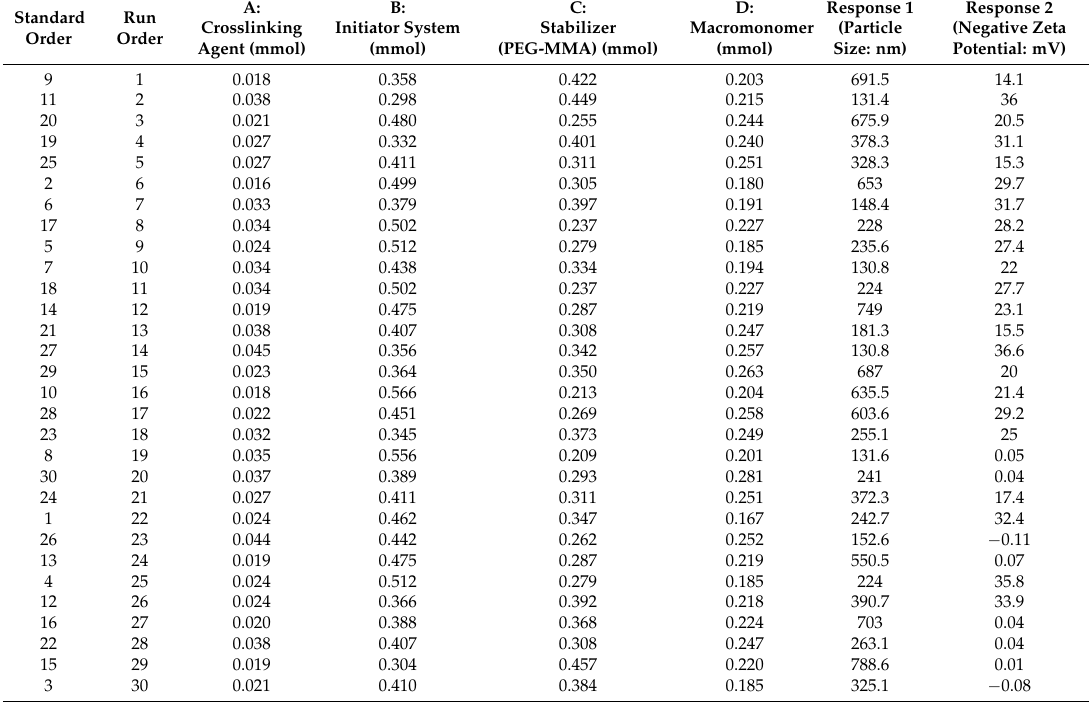
Table 2. Composition and response of D -optimal mixture experiemntal design for the fabrication of stealth poly- ε -caprolactone-based